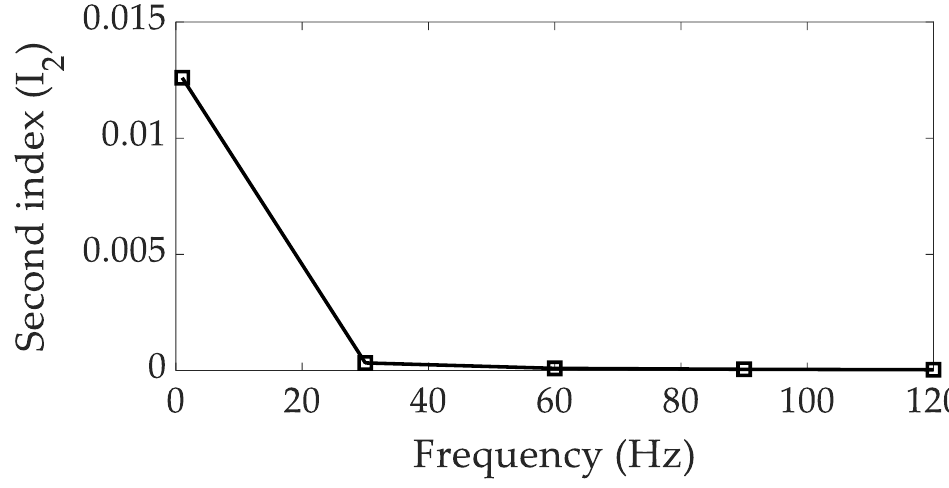
Figure 6. Variation in the second performance index as a function of frequency.